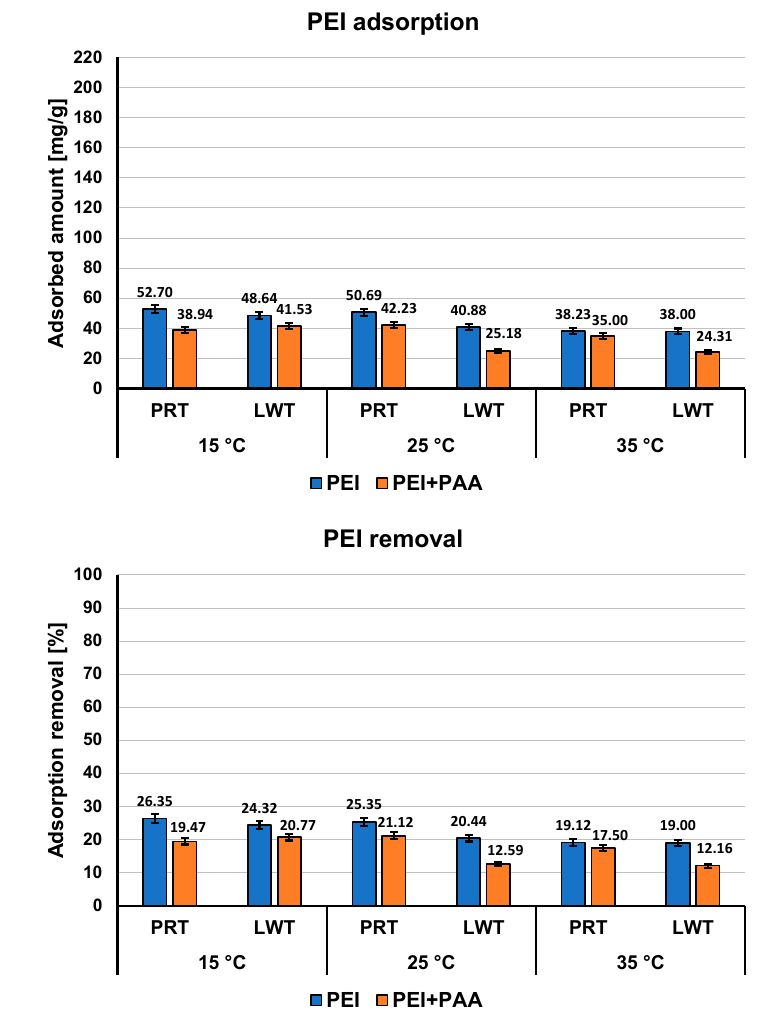
Figure 5. PEI adsorbed amounts ( a ) and its percentage removal ( b ) from the commercial materials surface in single and mixed systems of adsorbates at three examined temperatures, pH 3.